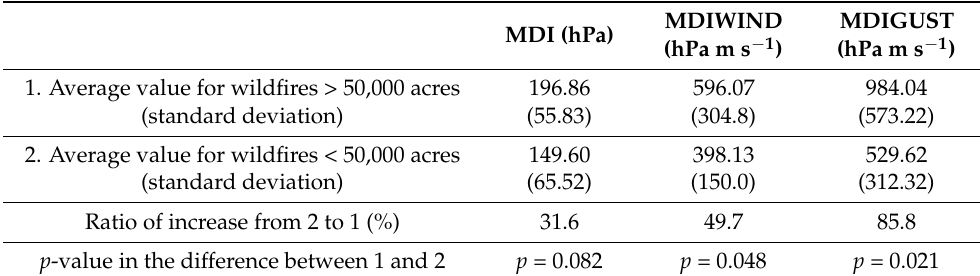
Table 4. Average values and their standard deviations of the daily averaged ignition location indices.